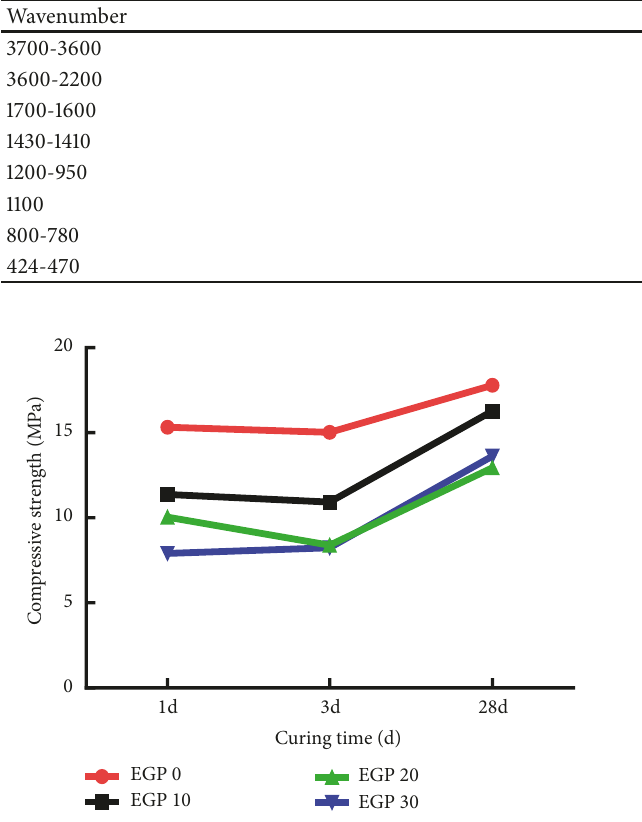
Figure 2: XRD patterns of different resin content geopolymers and